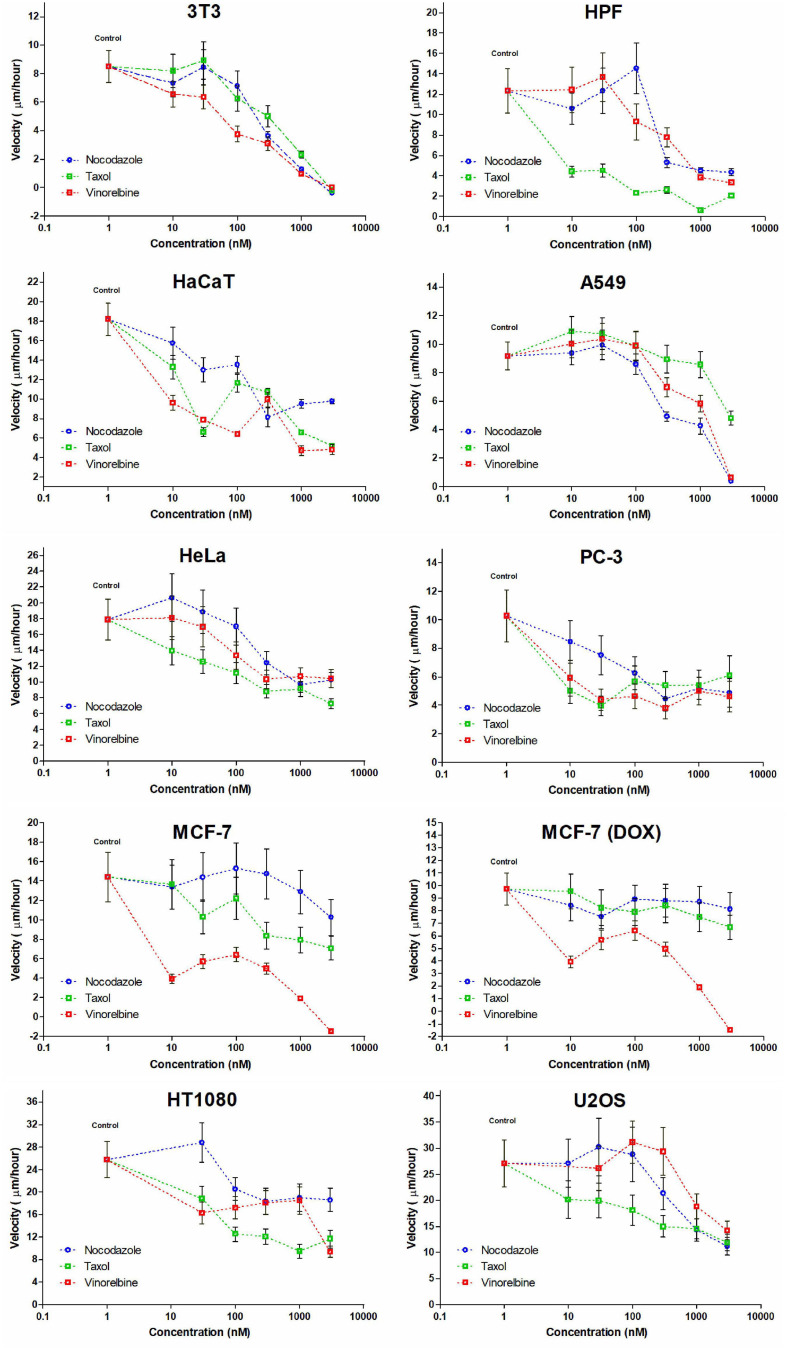
Dose-dependent effect appears not evenly for cell lines studied and IC50 estimations impossible for some cultures. Only in few cases, a decrease in cell velocity is monotonic (for HaCaT and A549 cells under treatment by nocodazole, HeLa, and U2OS cells with similar gradual response for Taxol and for 3T3 cells under treatment by vinorelbine).